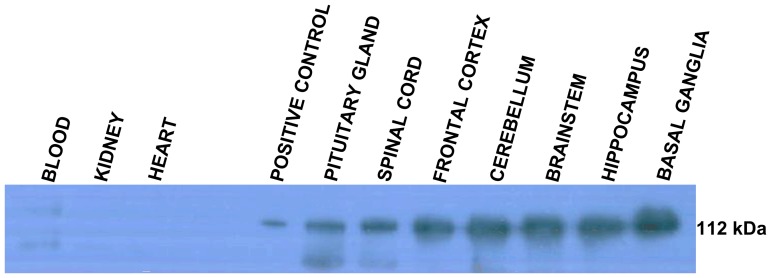
Western blot showing the α3-isoform specifically expressed in porcine neural tissues.An α3-specific antibody reactive band of approximately 112 kDa corresponding to Na+/K+-ATPase is present in all brain tissues analyzed and in the spinal cord. Cell lysate from COS-1 cells stably expressing ATP1A3 was used as positive control.